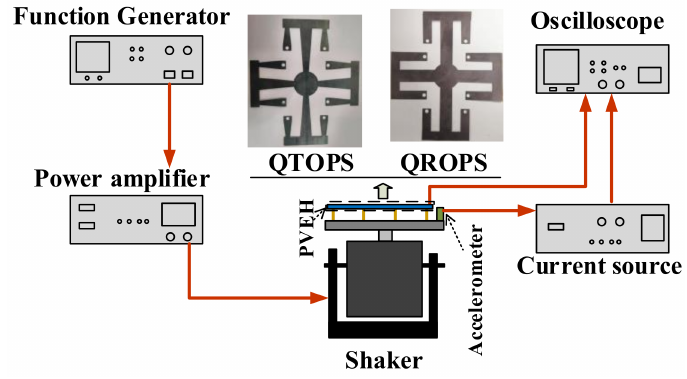
Figure 8. Experimental